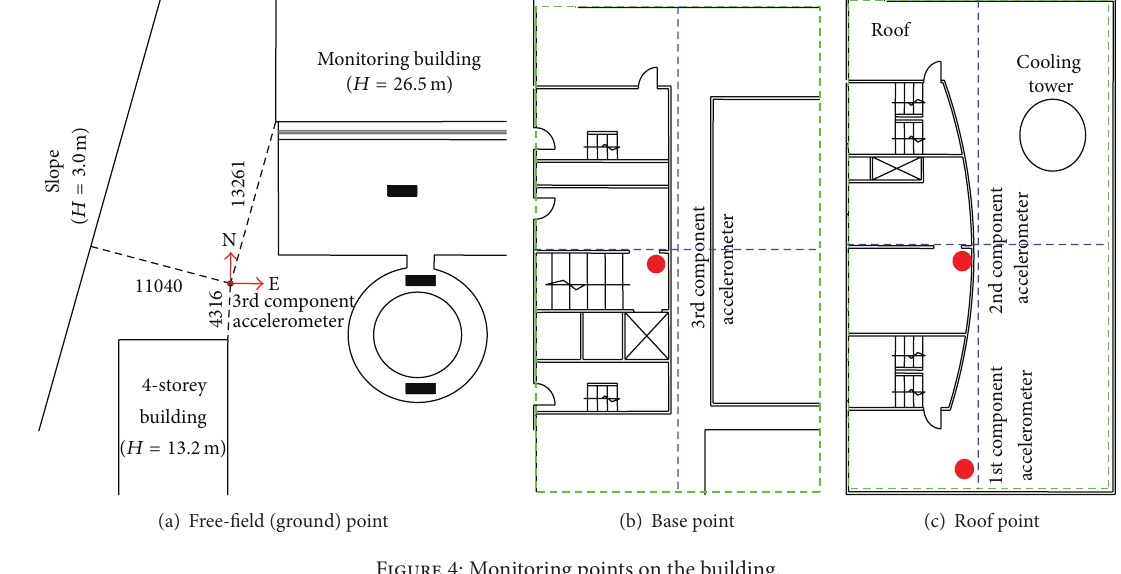
Figure 4: Monitoring points on the building.